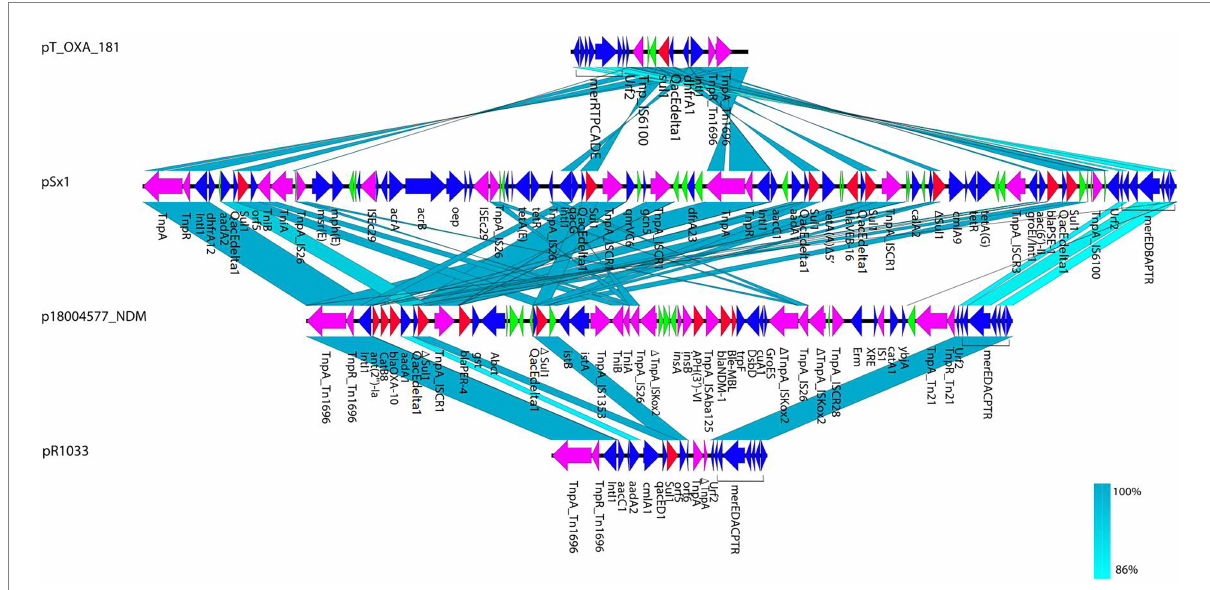
FIGURE 5 Structural comparisons of Tn1696 from p18004577_NDM, pSx1 (accession no. CP013115), pT_OXA_181 (accession no. JQ996150), and pR1033 (accession no. U12338). Arrows indicate the deduced open reading frames (ORFs) and their orientations. Blue arrows were used for ORFs encoding plasmid basic functions and green arrows expressing hypothetical proteins. Resistance genes are indicated by red arrows, while transposon-related genes (tnpA and tnpR) and insertion sequences are indicated by purple arrows.